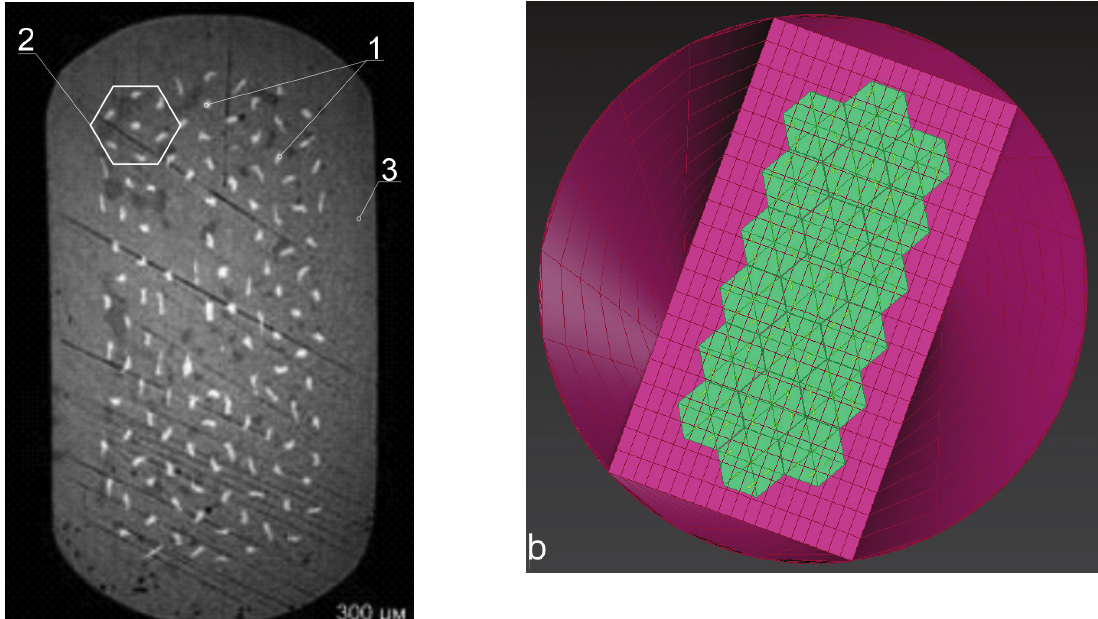
Figure 3. IVG.1M reactor fuel element: a. Actual configuration (1 – uranium filaments; 2 – cell with uranium filaments; 3 – fuel element coating); b. Scheme of the computational model for the MCNP5